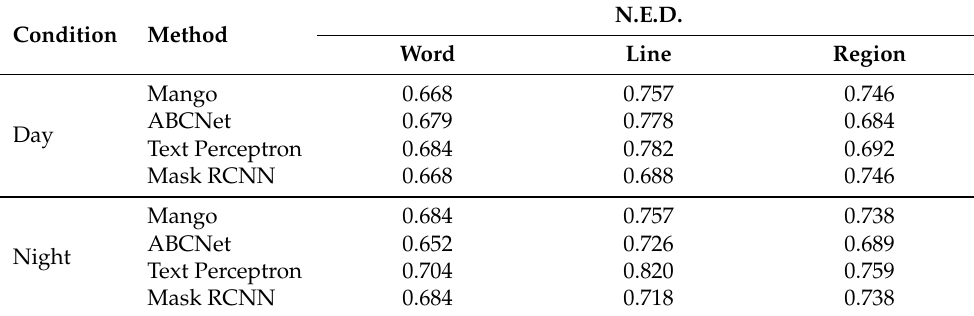
Table 1. Evaluation of E2E text spotters.